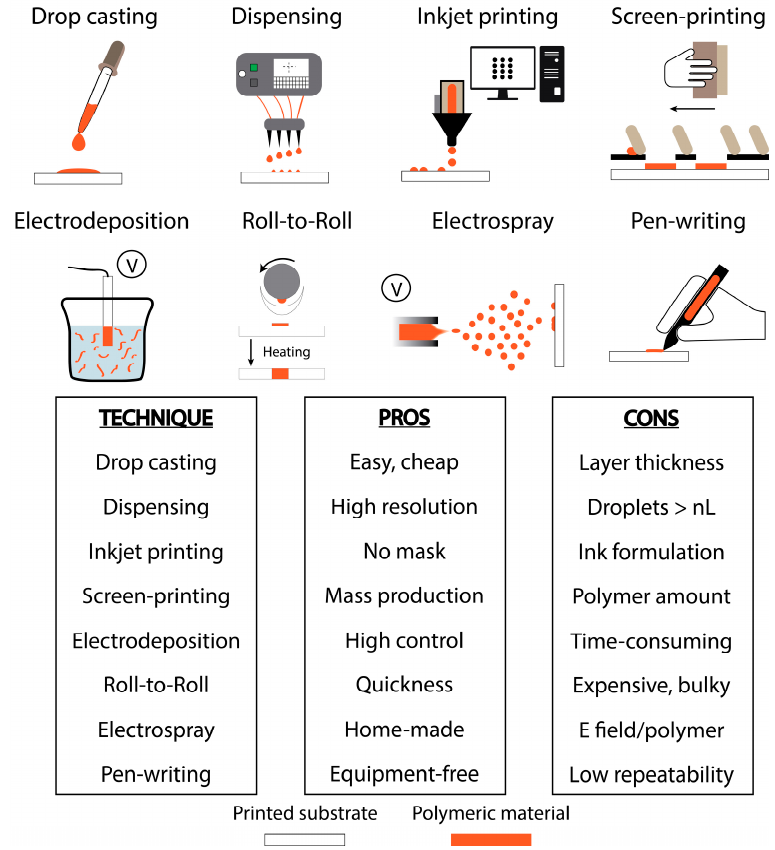
Figure 1. Scheme of the main utilized techniques that are used to modify printed electrochemical devices with polymeric materials.